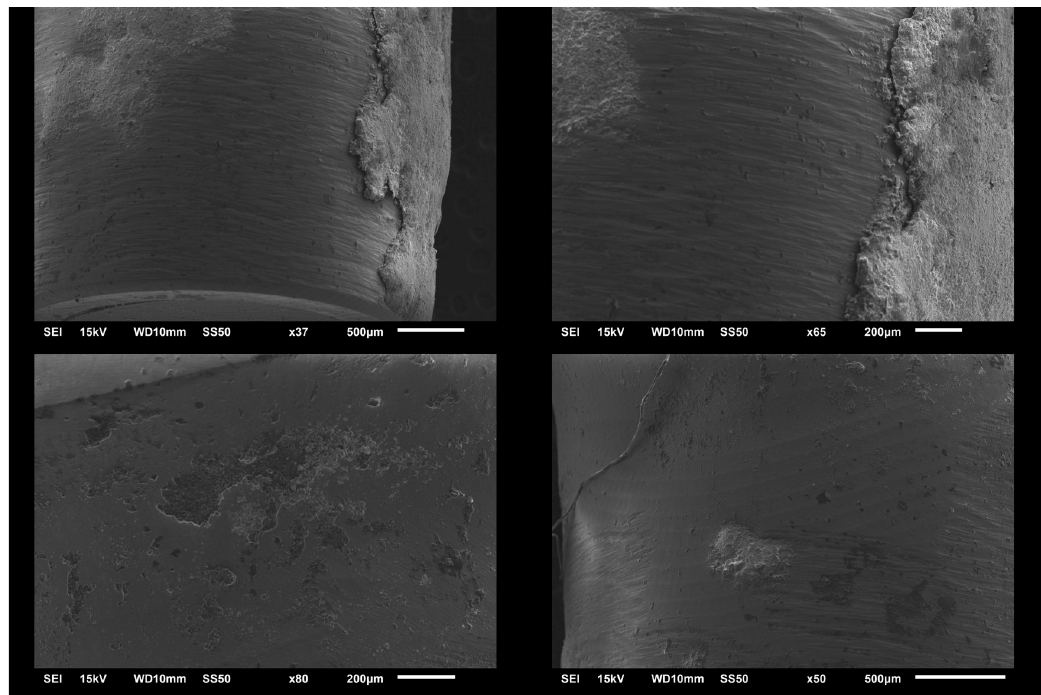
Fig 4. SEM images zirconium abutment without irradiation and after irradiation at 200 μ m and 500 μ m scale. Note residual cement on intact abutment surface. Top left (500 μ m) and right (200 μ m) demonstrates area of zirconia abutment surface with residual cement. Bottom left (200 μ m) and right (500 μ m) demonstrate the area of zirconia abutment without residual cement. Note normal smooth surface without any noticeable damage of zirconia.